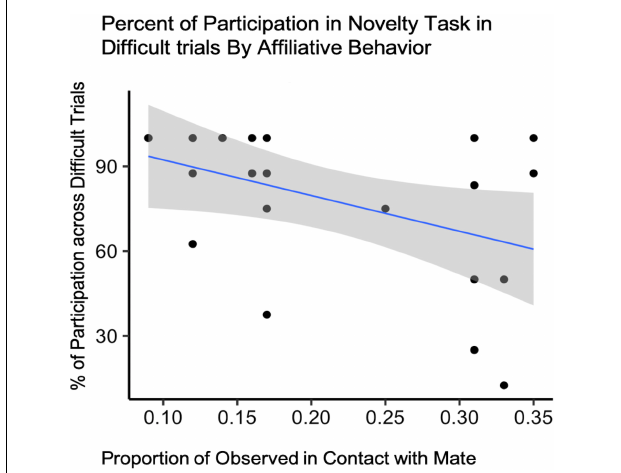
FIGURE 4 | Novelty response task participation ( N = 11) by Affiliative Contact. Percentage of subject participation across difficult trials plotted against the proportion of time subjects were observed in contact with their